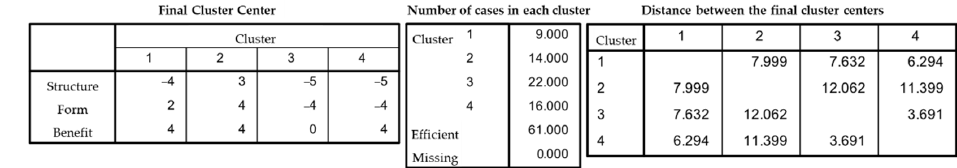
Figure A3. K ‐ means clustering analysis of historical buildings after renovation.